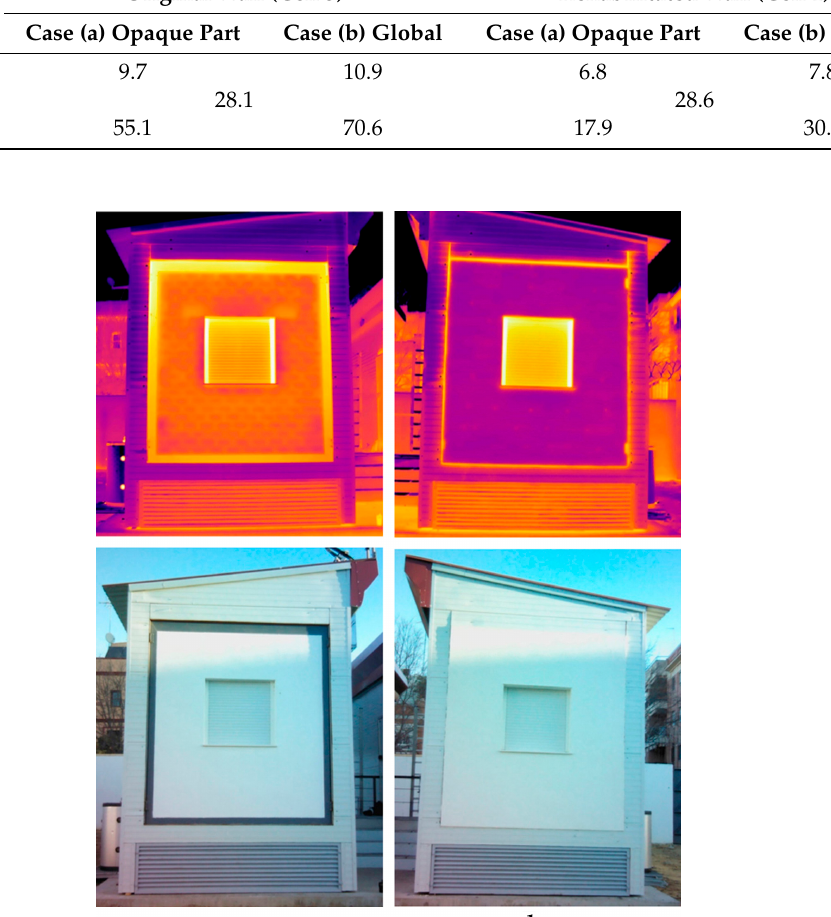
Table 8. The external surface temperature and estimated heat flux.